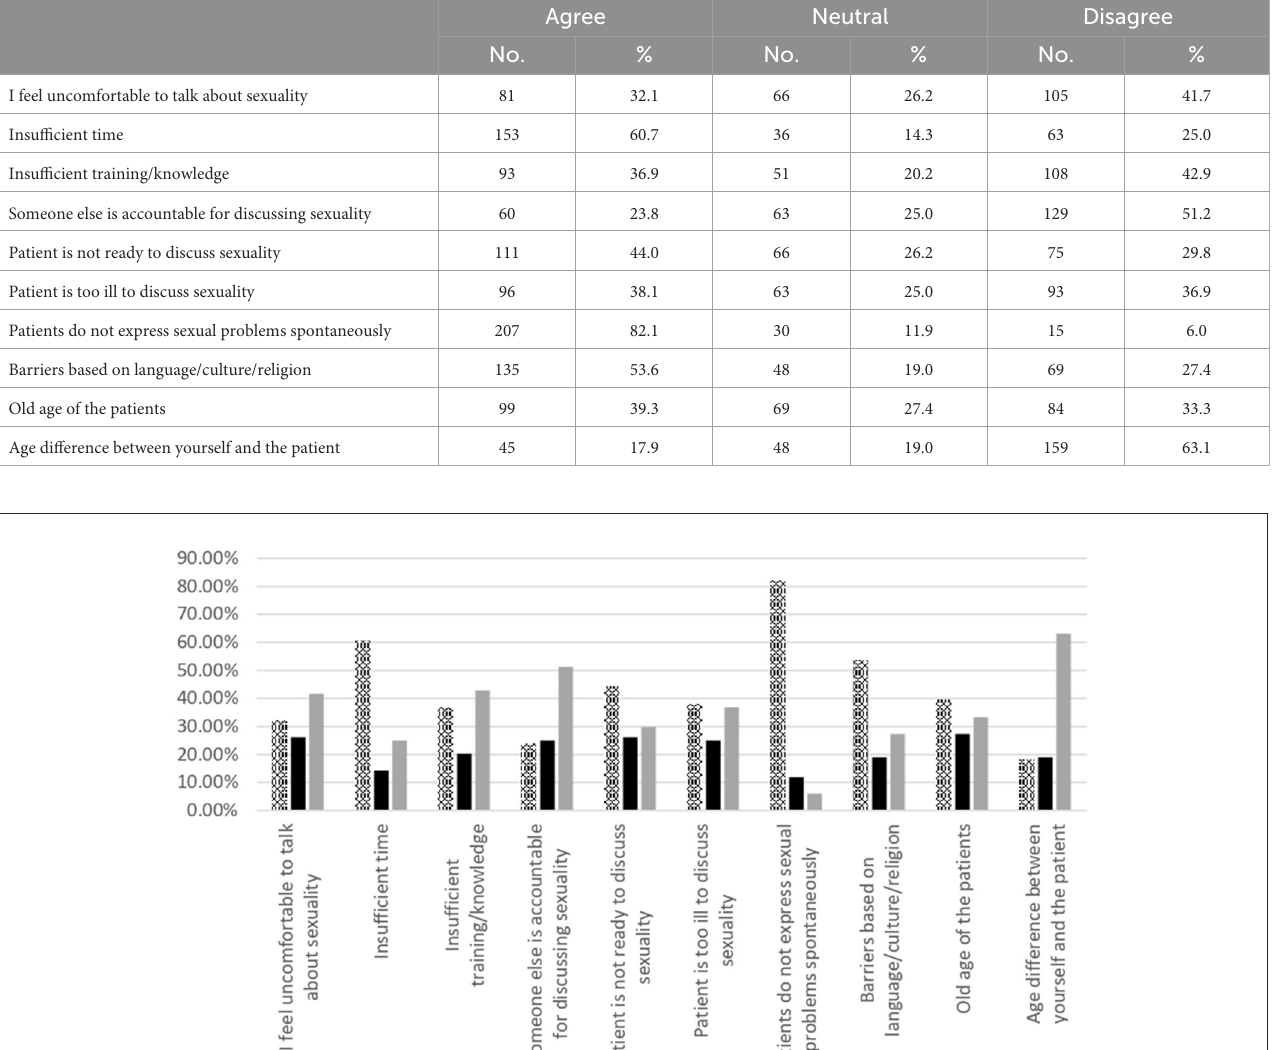
TABLE 3 Barriers toward discussing sexuality.